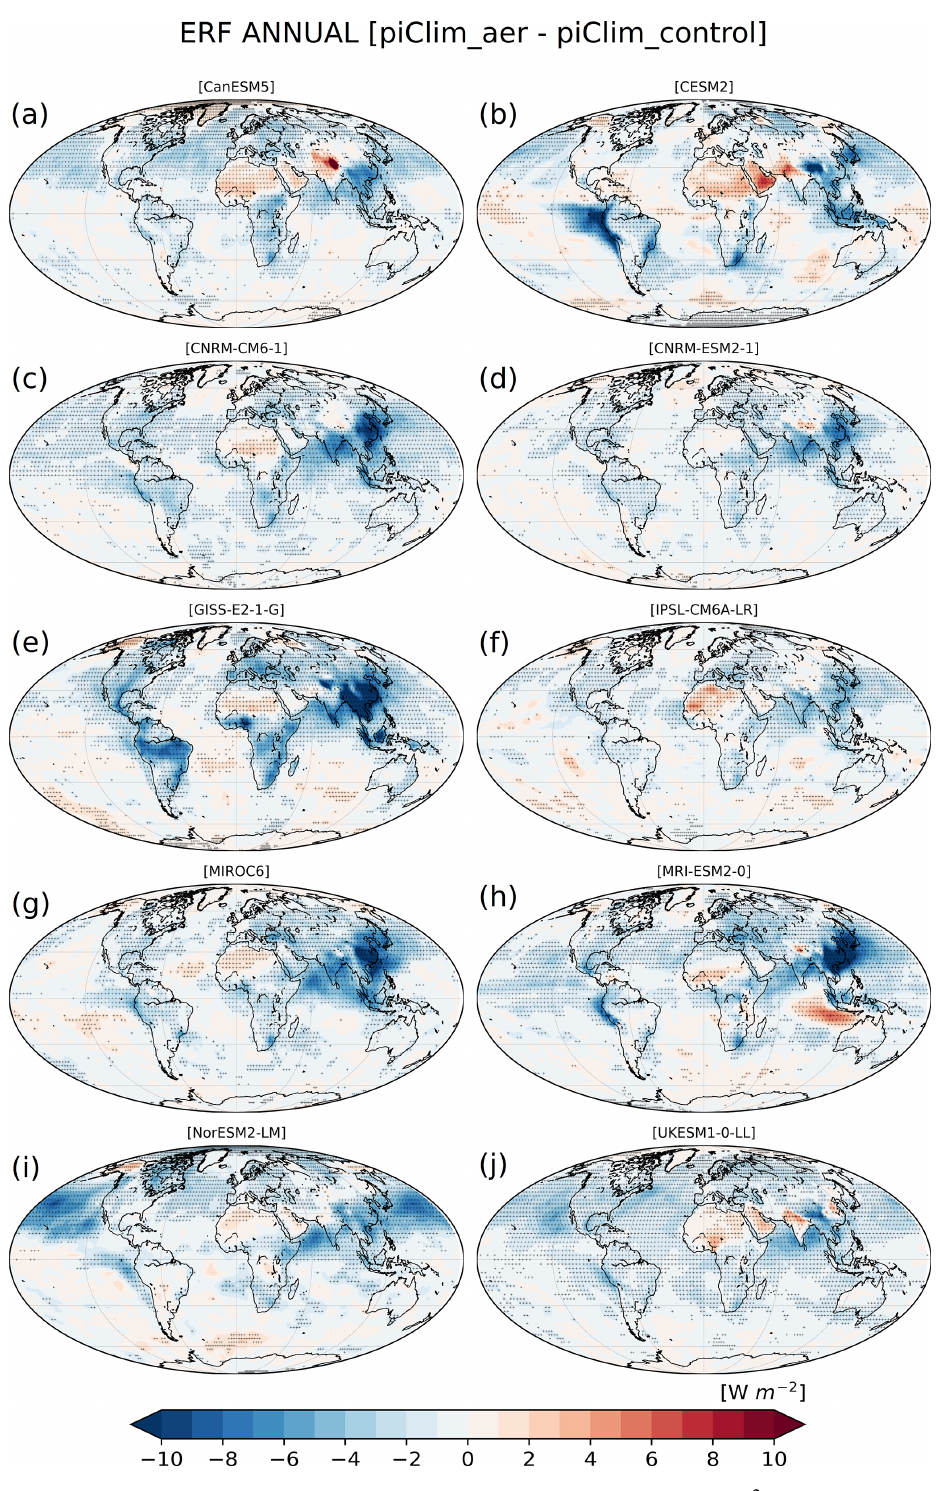
Figure 4. Annual differences between piClim-aer and piClim-control in the net radiative flux (Wm − 2 ) at TOA including both SW and LW (aerosol ERF) for each one of the models used for the ensemble. The dot shading indicates areas in which the differences are statistically significant at the 95% confidence